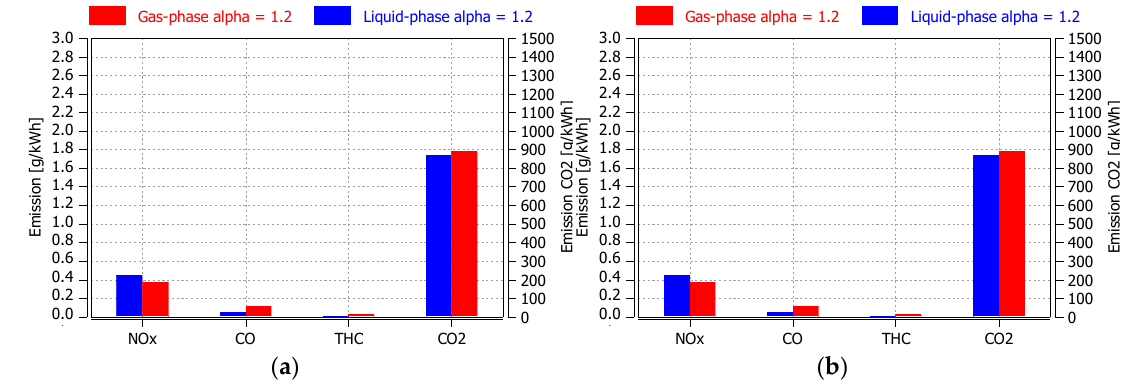
Figure 5. Comparison test results of liquid and gaseous urea ‐ dosing on World Harmonized Transient Cycle (WHTC), hot ‐ cycle at α = 1.2, ( a ) modal analysis, ( b ) emission results.